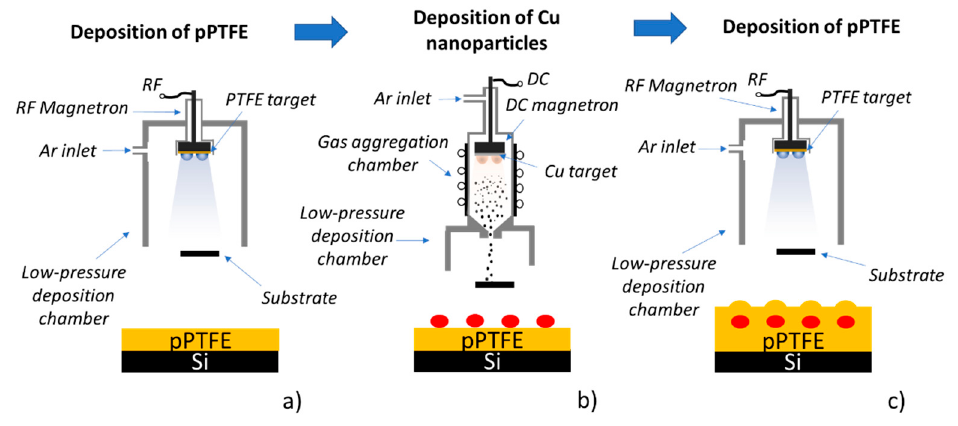
Figure 1. ( a ) Deposition of pPTFE layer. ( b ) Deposition of Cu nanoparticles. ( c ) Overcoating Cu Nps with pPTFE film.